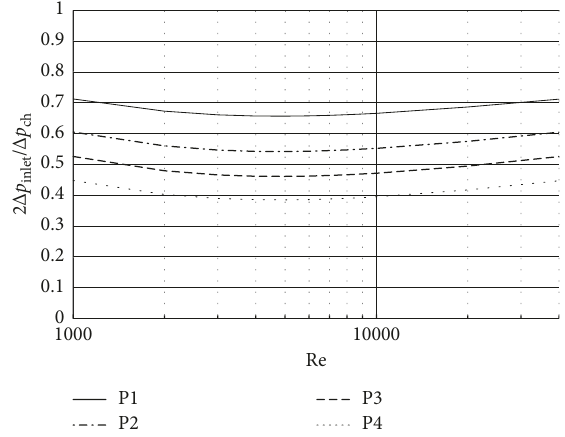
Re for plates P1–P4 for LL ( )